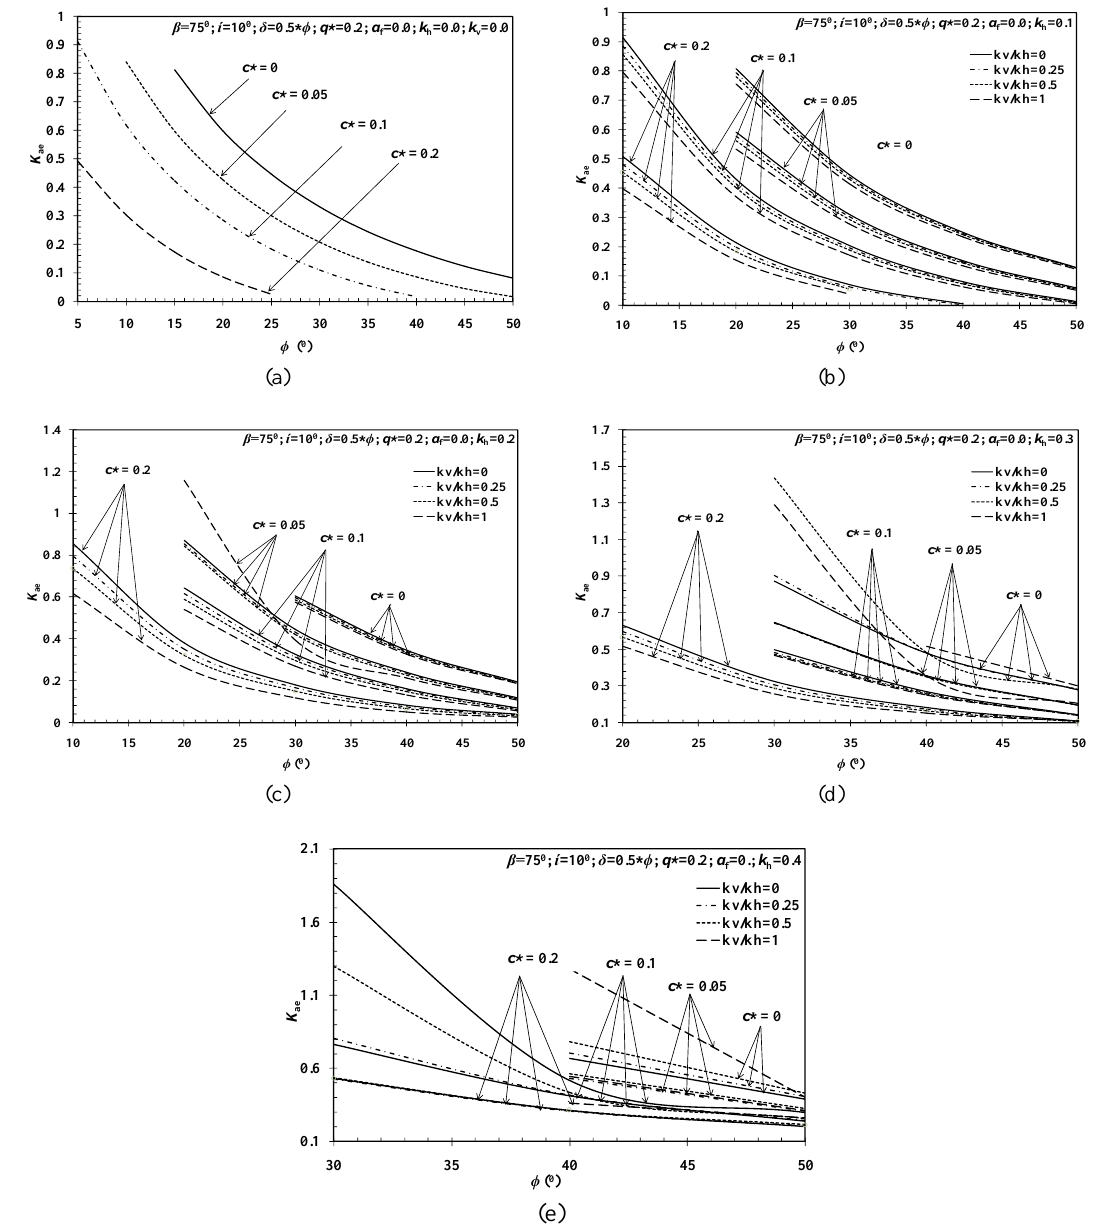
Figure 4. Design charts for K ae for backfill slope i = 10 o and wall inclination β = 75